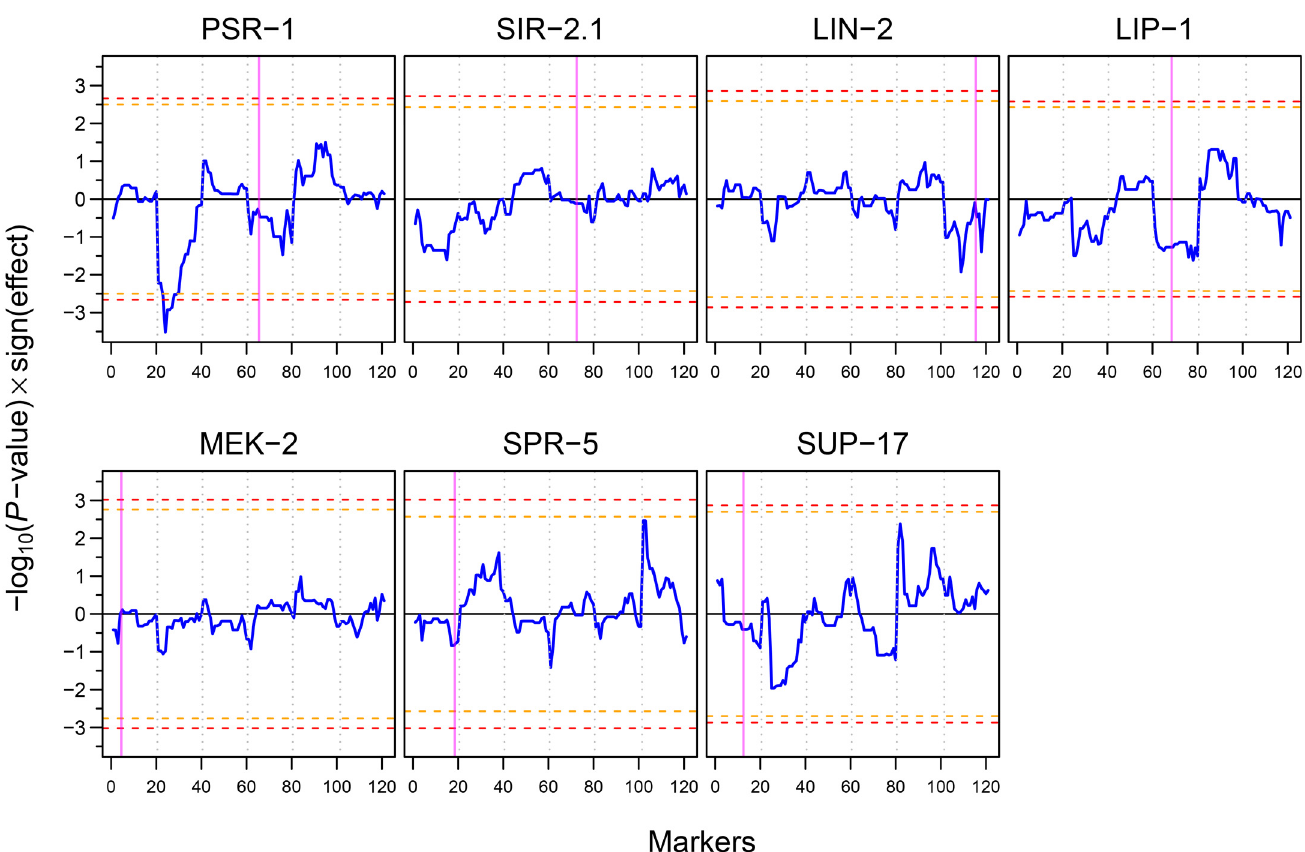
Fig 5. pQTL profiles of seven selected signalling pathway proteins. Blue curves show the significance of the pQTLs multiplied by the sign of the effect of the N2 allele (positive values of blue curve indicate higher protein abundance when the N2 allele is present, whereas negative values indicate higher protein abundance when the CB4856 allele is present). Horizontal orange and red dashed lines show 0.1 and 0.05 FDR thresholds respectively. Vertical dotted grey lines separate chromosomes I to V and X from left to right. Vertical magenta bands indicate the position of the gene in the genome. PSR-1 shows a significant pQTL on the left arm of chromosome